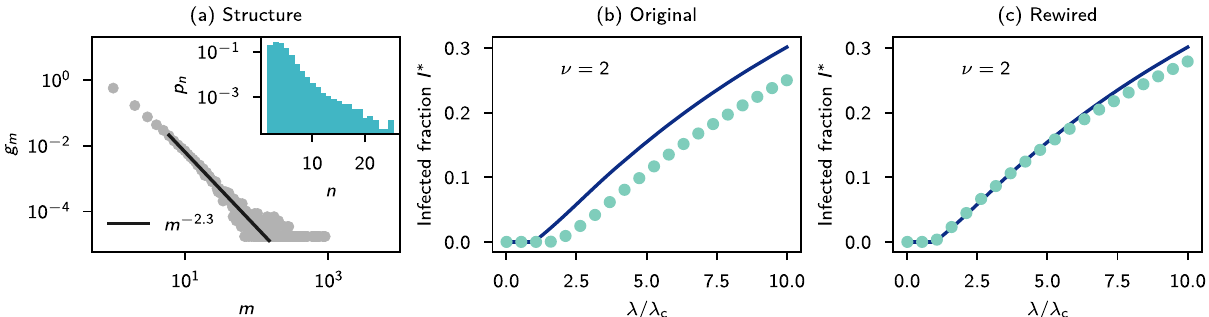
Fig. 3 Phase transition on a hypergraph constructed from coauthorship data. See “ Contagion on real-world hypergraphs" in “ Methods. ” The hypergraph has been obtained by using a breadth- fi rst search to extract a subhypergraph of 57,501 nodes and 55,204 groups; the original data contained more than 10 6 nodes and groups. a The membership distribution is heterogeneous, approximately of the form g m (cid:5) m (cid:2) γ m with 〈 m 〉 ≈ 3.75 and m max ¼ 903, while the group size distribution (inset) is more homogeneous, with 〈 n 〉 ≈ 3.90 and n max ¼ 25. b , c We compare the results of Monte Carlo simulations (circle markers) with the predictions of our approach (solid lines). The infection rate function is β ( n , i ) = λ i ν . We rescale λ with the invasion threshold λ c , which is computed using Eq. (15). The infected fraction I * has been obtained as averages over time with long runs (and averaging over randomized hypergraphs when this applies). The error bars (too small to be seen) correspond to one standard deviation. We used ordinary simulations, starting with I = 0.8. b We use the original hypergraph. c We use 10 uniformly randomized versions of the original